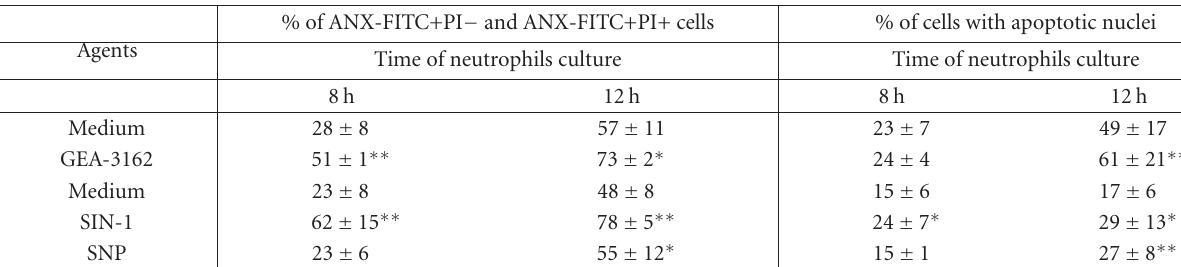
Table 2. E ff ect of exogenous superoxide dismutase (SOD) on apoptosis of neutrophils nontreated and treated by NO donors in vitro measured by ANX-FITC and PI binding. Neutrophils (1 × 10 6 cells) were incubated at 37 ◦ C with the indicated stimuli in the presence of SOD (300U/mL) or not for 8 and 20 hours and apoptosis was determined as described in “materials and methods.” Results are given as means and SD percentages of the sum of cells binding ANX-FITC+PI − and ANX-FITC+PI+ for 6 separate experiments. Statistical significance: ∗∗ denotes neutrophils with SOD versus neutrophils with GEA-3162, SIN-1 ( P ≤ . 05); ∗ denotes neutrophils with GEA-3162+SOD and with SIN-1+SOD versus neutrophils with GEA-3162 and SIN-1, respectively ( P ≤ . 05). nd means no data. % of ANX-FITC+PI − and ANX-FITC+PI+ cells Agents Time of culture 8h 12h